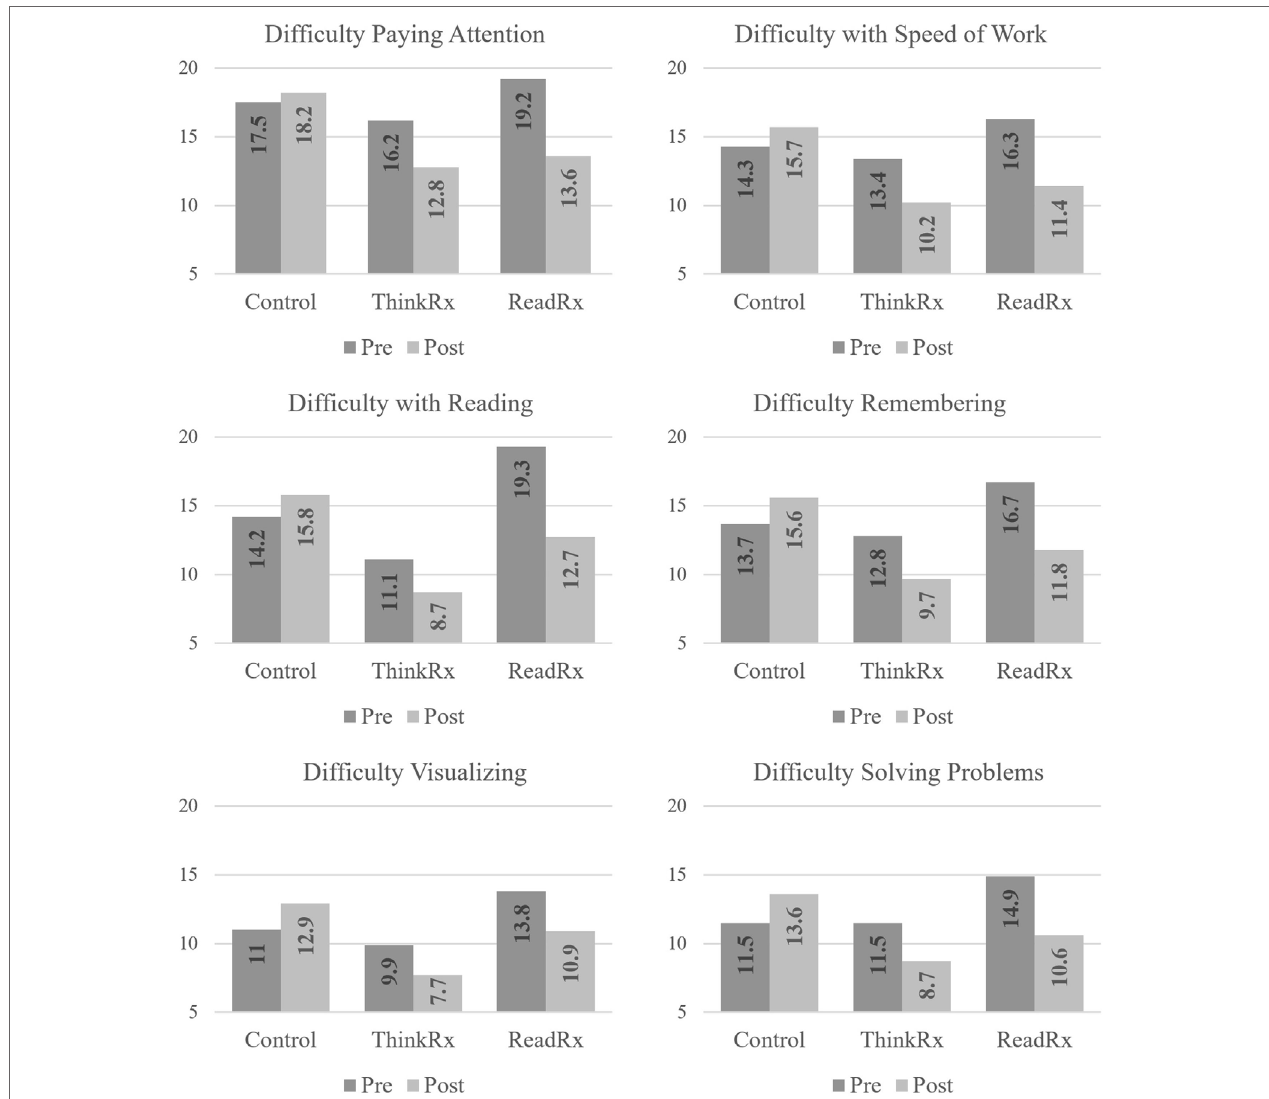
FigUre 2 | Pre-training and post-training parent ratings in academic